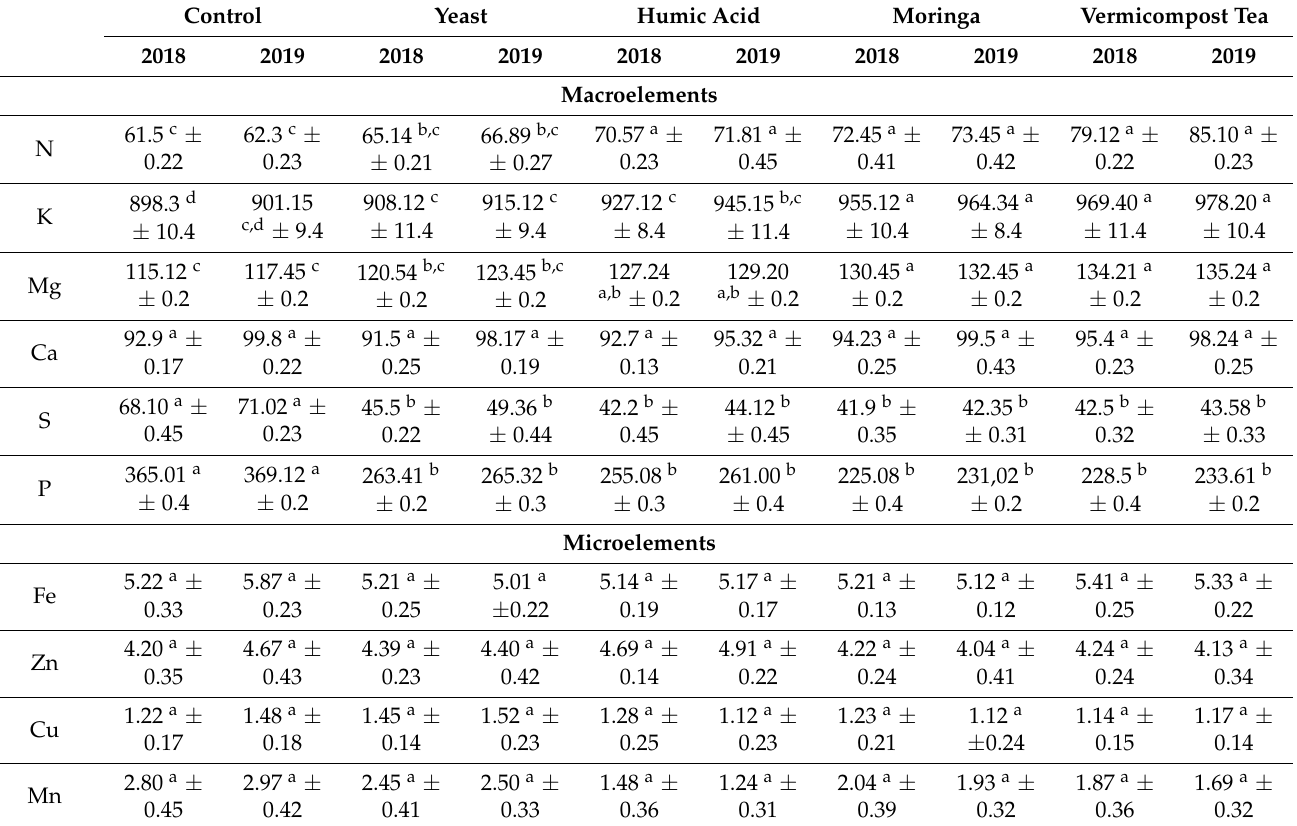
Table 10. Effect of biostimulants on mineral content (mg/kg) of snap bean in growing seasons of 2018 and 2019. Control Yeast Humic Acid Moringa Vermicompost